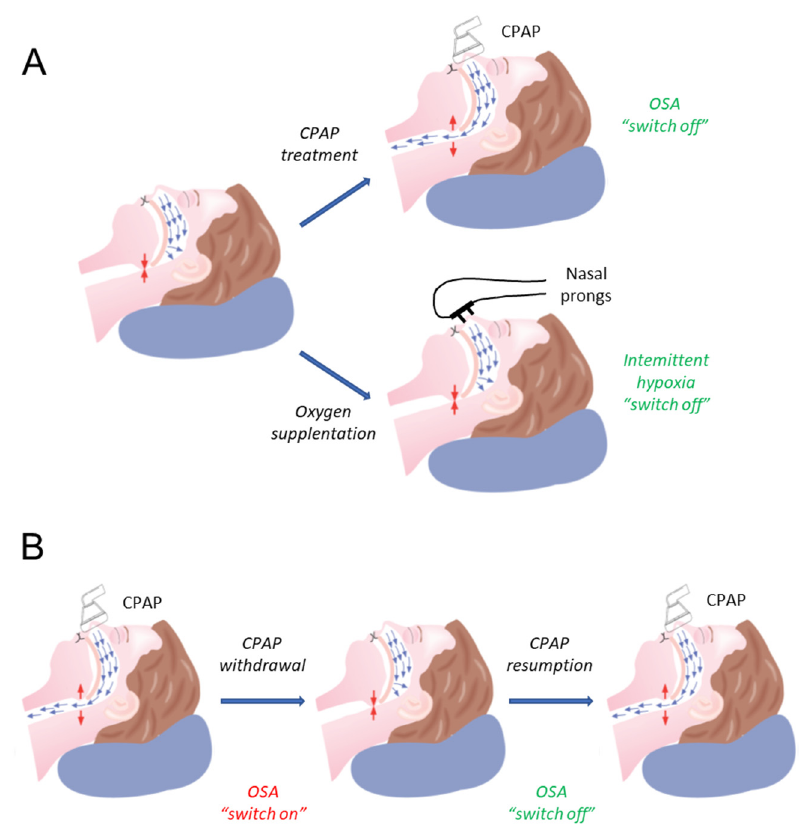
Figure 4. Experimental patient models to study the mechanisms involved in obstructive sleep apnea (OSA) consequences. ( A ) Model of supplementary nocturnal oxygen therapy. Patients with OSA experiencing upper airway collapse (with associated intermittent hypoxemia, sleep fragmentation and increased intrathoracic pressure swings) can be subjected either to continuous positive airway pressure (CPAP) therapy (equivalent to “switching off” OSA if CPAP is effective) or to supplementary oxygen therapy to avoid only the recurrent oxygen arterial desaturations induced by OSA. ( B ) Model of CPAP withdrawal. Patients effectively treated with CPAP (therefore not experiencing OSA challenges) are modelling “normal” subjects as compared with the same patient after CPAP withdrawal, an intervention equivalent to “switching on” OSA. Resumption of CPAP after withdrawal recovers the baseline condition. Comparison of patient status after “switching on and off” OSA provides information on the mechanisms involved in the consequences of this sleep-breathing disorder. Reprinted with permission from Ref. [173]. 2021. European Respiratory Society.